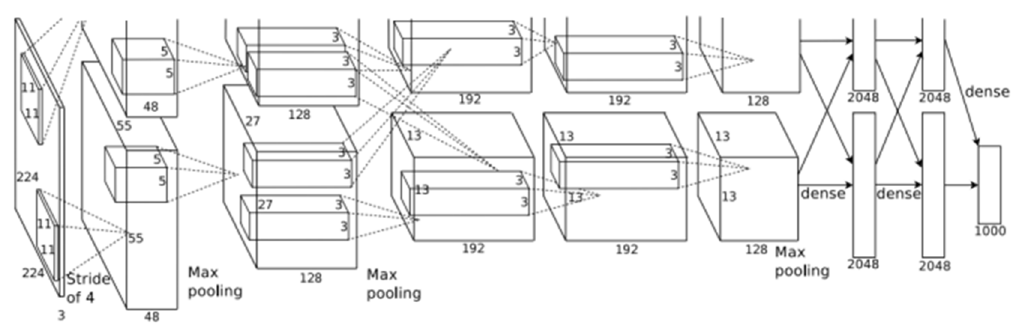
Figure 5. AlexNet network structure.